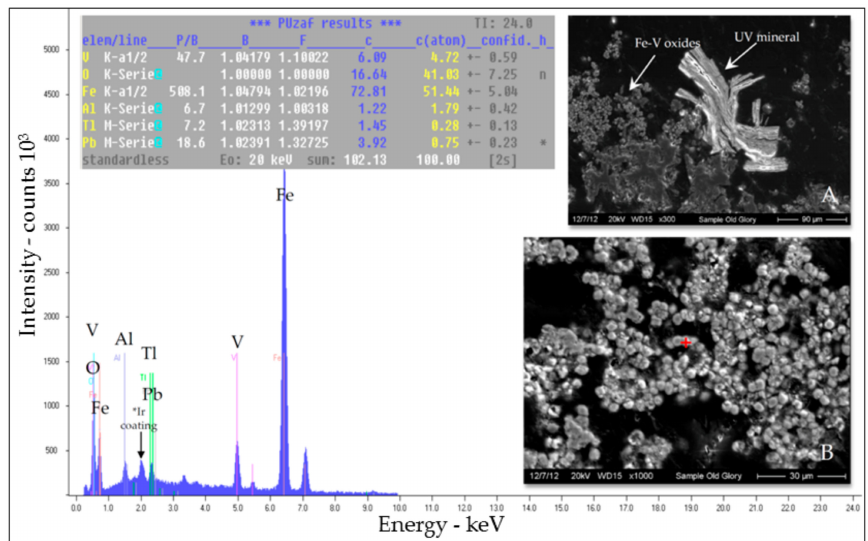
Figure A7. EDS spectrum collected from + from Fe-V oxides in sample from the Old Glory mine, PMD. The elements V, Fe, Tl, Pb, Al and O were detected. These oxides have a lighter colored rim indicating element(s) with larger Z. The rims of the oxides may have the Tl and or Pb. Sample was coated with Ir. The Ir peak is denoted by the *Ir and arrow. Ir coating was subtracted out before the quantification was performed by the program utilized by the